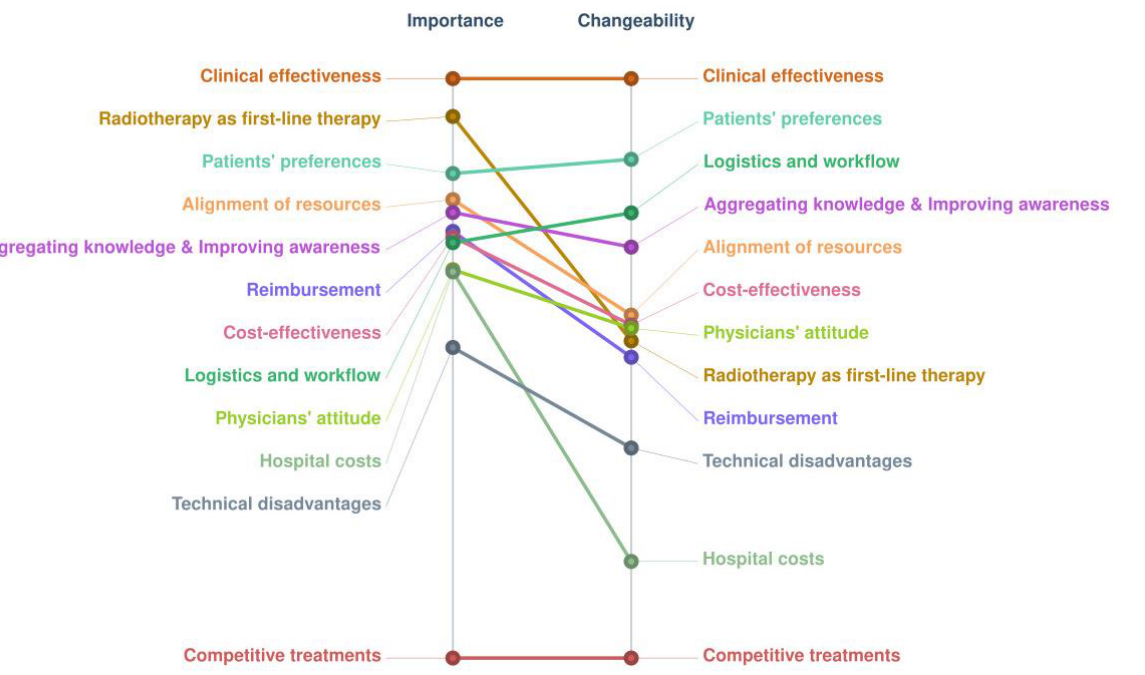
Figure 3. Comparison of the two rating dimensions, importance vs. changeability of clusters. Pattern matches show the average rating value (calculated from Likert scales ranging from 0 to 4), considering results from all participants.